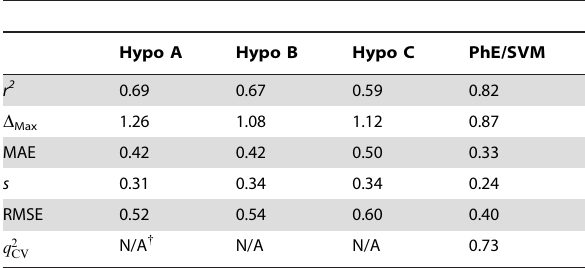
Table 1. Statistic parameters correlation coefficient ( r 2 ), maximum residual ( D Max ), mean absolute error (MAE), standard deviation of residual ( s ), RMSE, and cross-validation coefficient q 2 evaluated by Hypo A, Hypo B, Hypo C, and CV PhE/SVM in the training set.